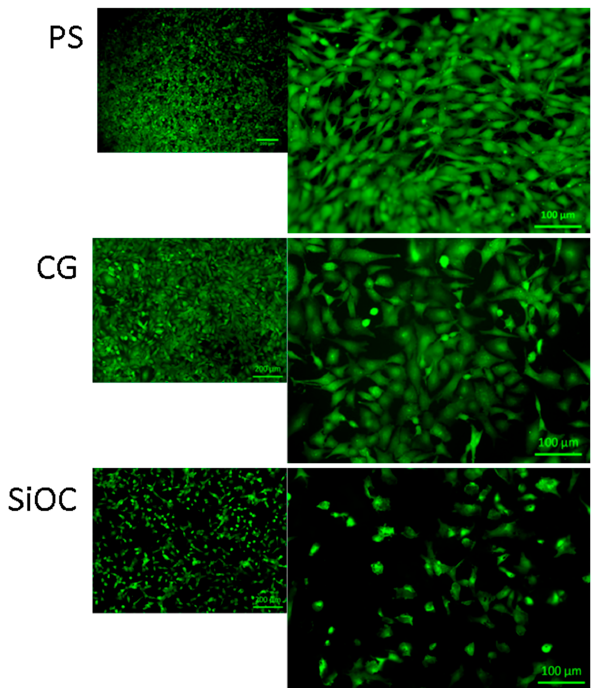
Figure 6. Fluorescence micrographs (FM) of MEF cells in direct contact with polystyrene (PS, top ), cover glass (CG, middle ), and SiOC ( bottom ) samples after 24 h of incubation. The green color corresponds to the staining of the cell cytosol of the living cells.